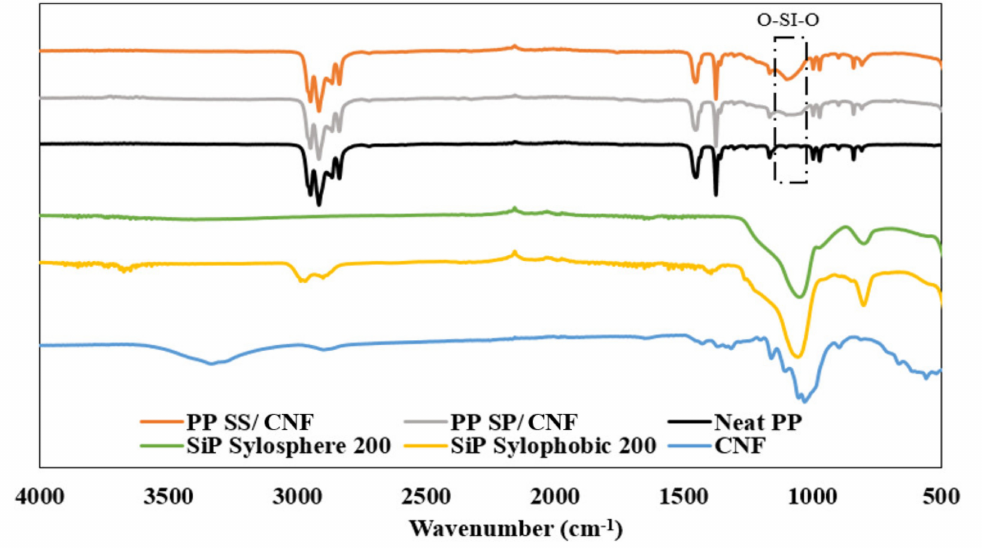
Figure 6. FTIR spectra of SiP Sylosphere 200, Sylophobic 200, CNF, and PP